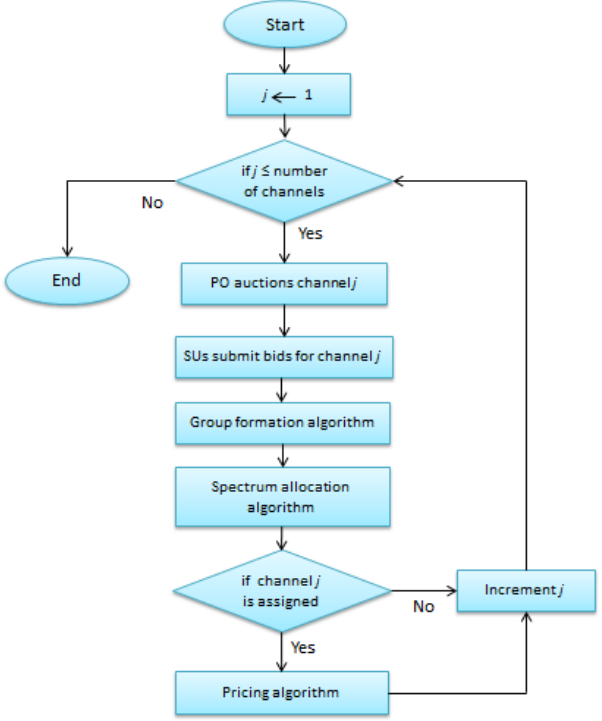
Figure 5. Flowchart representation of the proposed auction